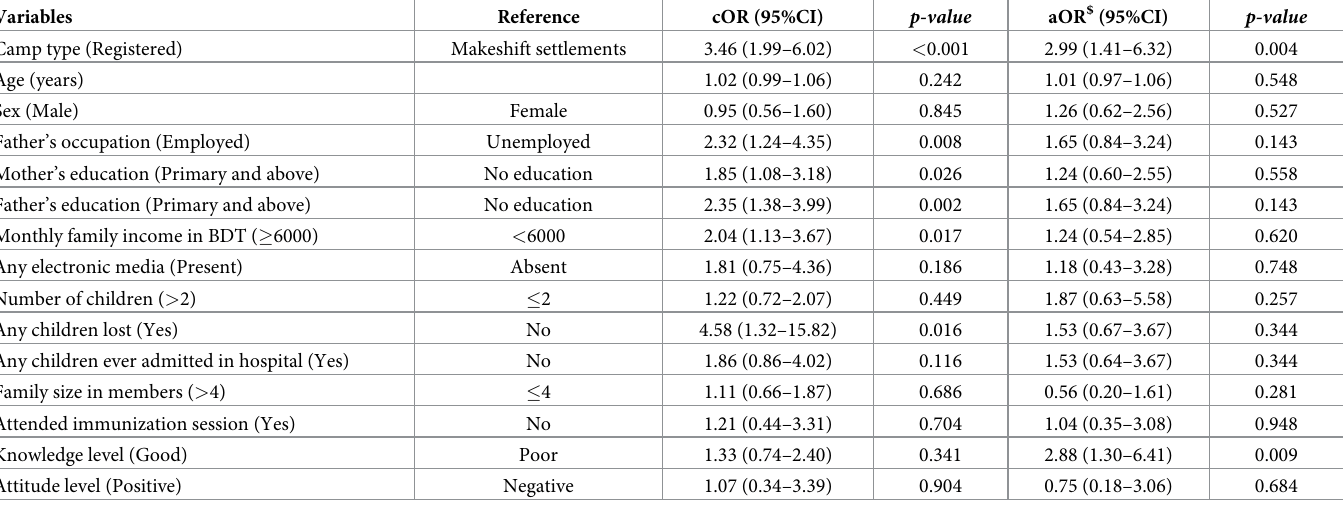
p-values are shown in bold; cOR: Crude Odds Ratio; aOR: Adjusted Odds Ratio $ Enter method was used for